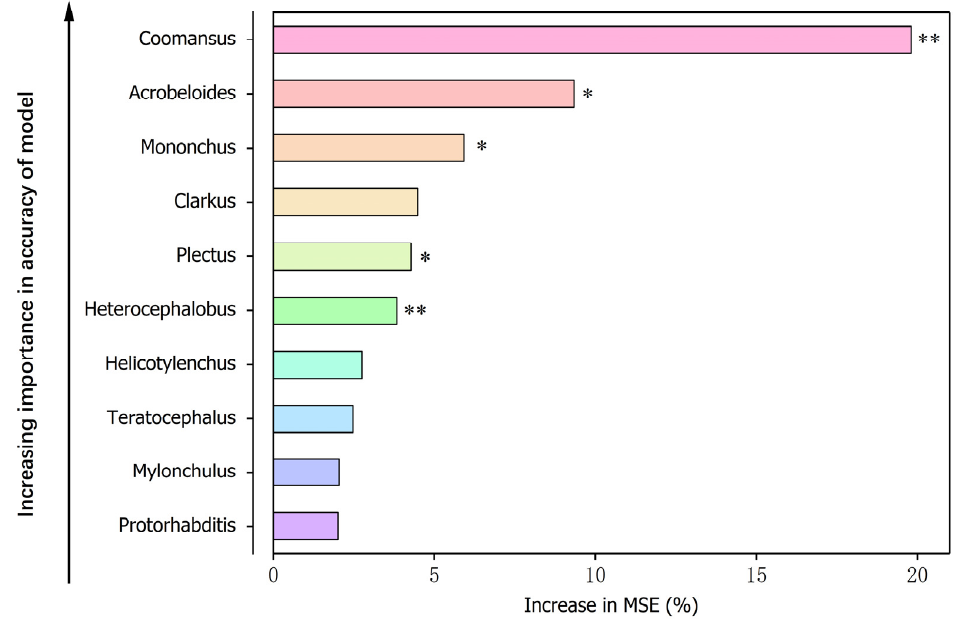
Figure 6. Random forest regression model showing the main nematode genera associated with SQI. * and ** indicate that the genera were significantly associated with SQI at p < 0.05 and < 0.01, respec- tively.